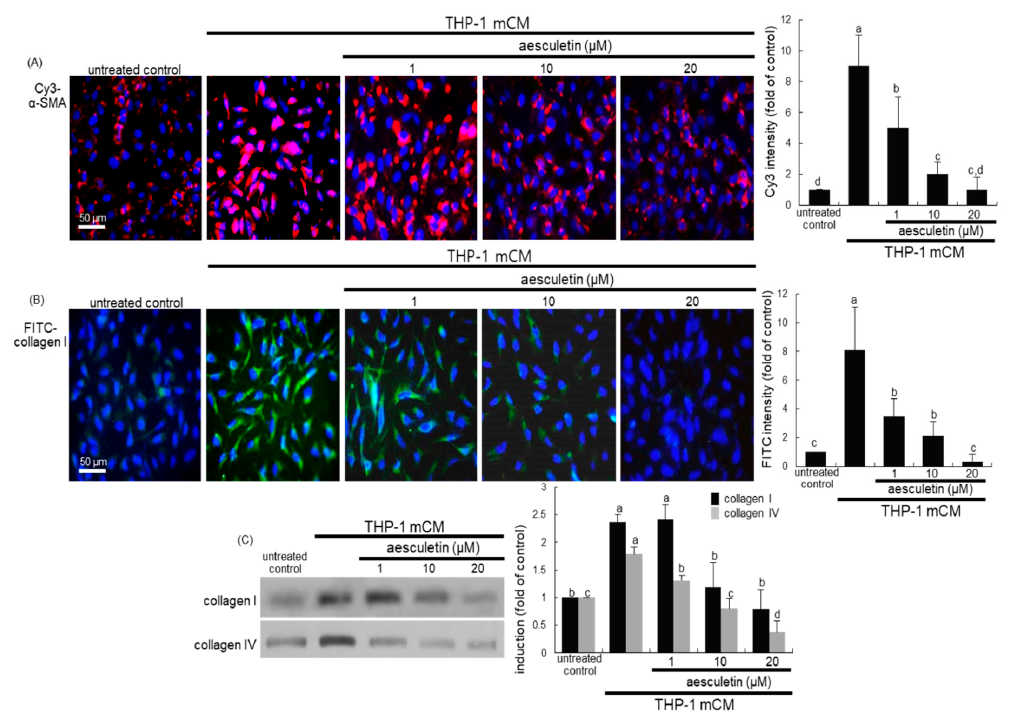
Figure 3. Immunocytochemical data showing inhibitory effects of aesculetin on induction of α -SMA and collagen I ( A , B ) and Western blot data showing inhibitory effects of aesculetin on secretion of collagen I and collagen IV ( C ). Alveolar epithelial A549 cells were incubated in THP-1 monocyte-derived macrophage conditioned media (mCM) for 24 h in the presence of 1–20 μ M aesculetin. α -SMA and collagen I of A549 cells was identified as Cy3-red staining or fluorescein isothiocyanate-green staining, respectively ( A , B ). Nuclear counter-staining was conducted with 4 ′ ,6-diamidino-2-phenylindole (blue). Fluorescent intensity of Cy3-red staining and FITC-green staining was measured using an optical Axiomager microscope system (mean ± SEM, n = 3). For the secretion of collagen I and collagen IV, cell lysates were subject to Western blot analysis with a primary antibody against collagen I and collagen IV ( C ). The bar graphs (means ± SEM, n = 3) represent quantitative results of the left bands obtained from a densitometer. Means without a common letter differ, p < 0.05. Scale bars = 50 μ m.